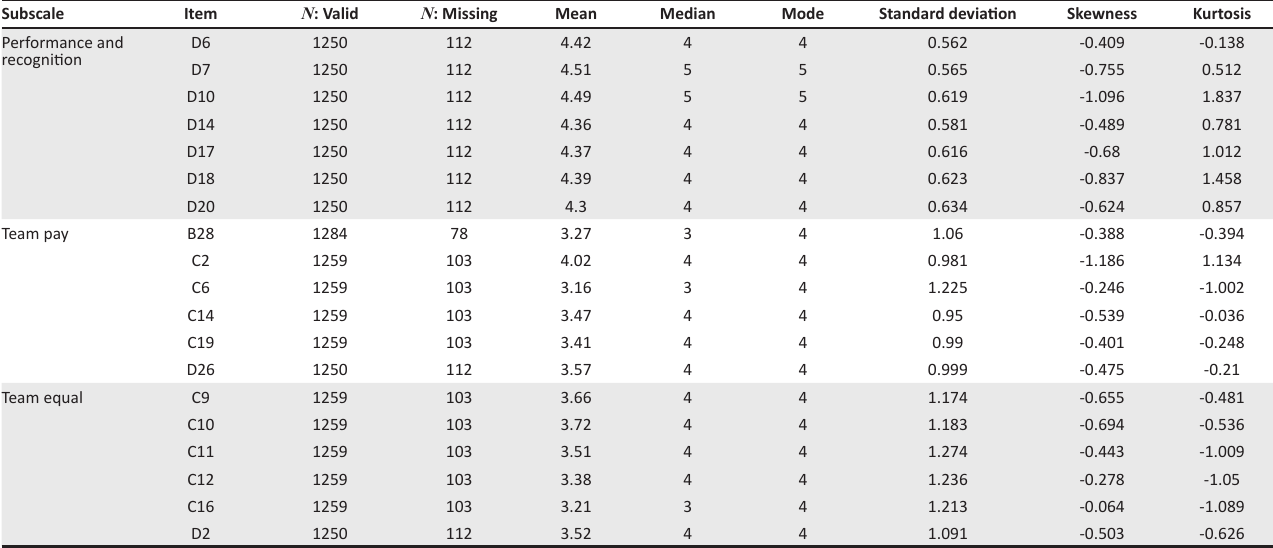
TABLE 5 (Continues...): Descriptive statistics for the reward preference scale (SARM10).